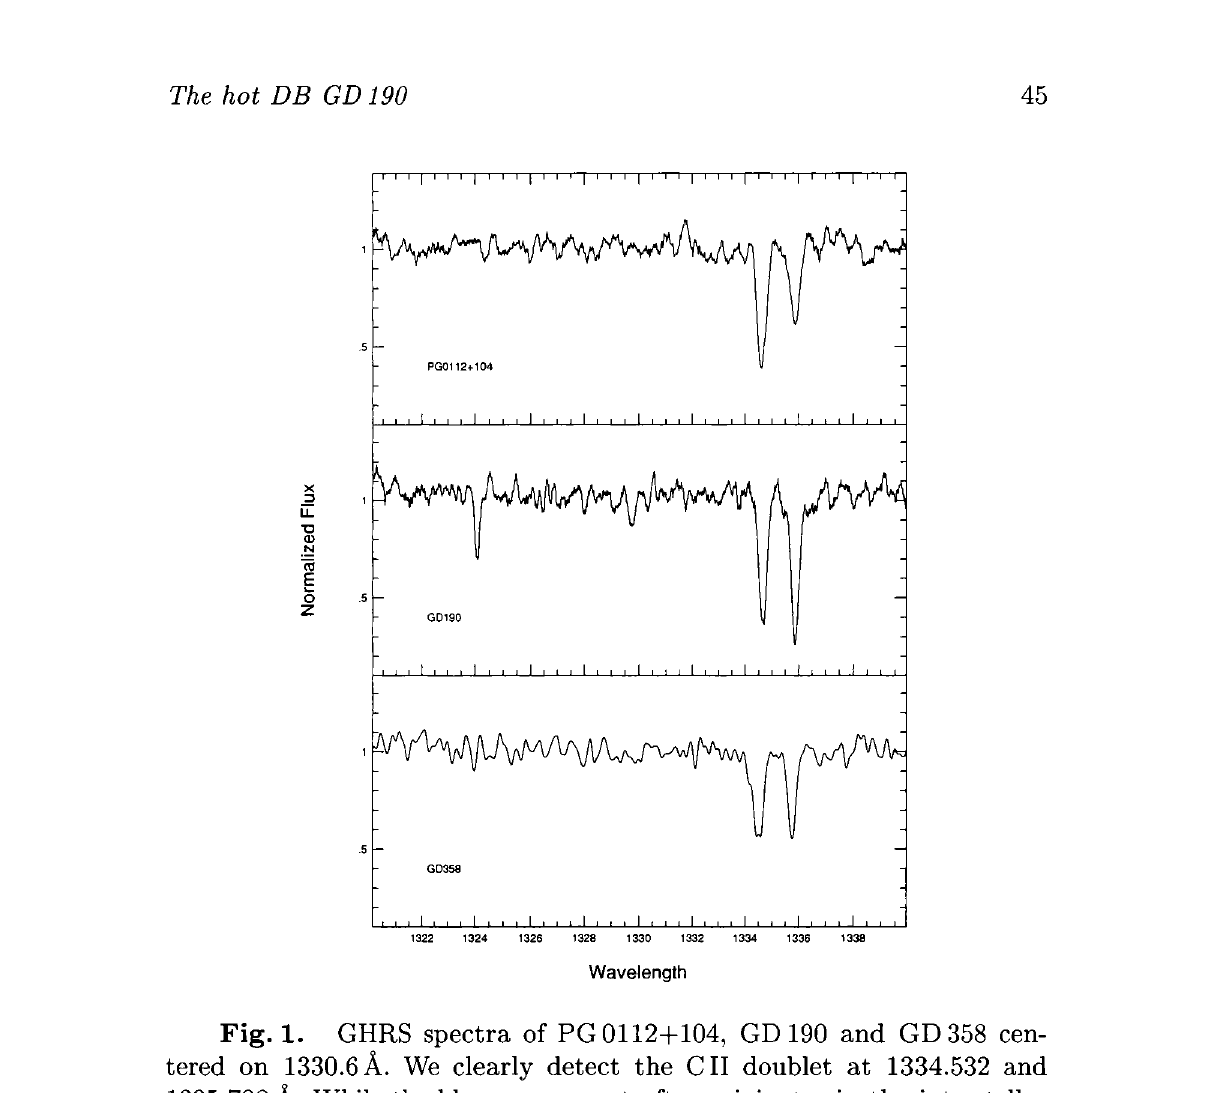
Fig. 1. GHRS spectra of PG 0112+104, GD 190 and GD358 cen- tered on 1330.6 A. We clearly detect the CII doublet at 1334.532 and 1335.708 A. While the blue component often originates in the interstellar medium, the 1335.708 A line results from transitions to a level slightly above ground state and depopulates spontaneously in the ISM. The pres- ence of both components demonstrates that the carbon is photospheric in all three